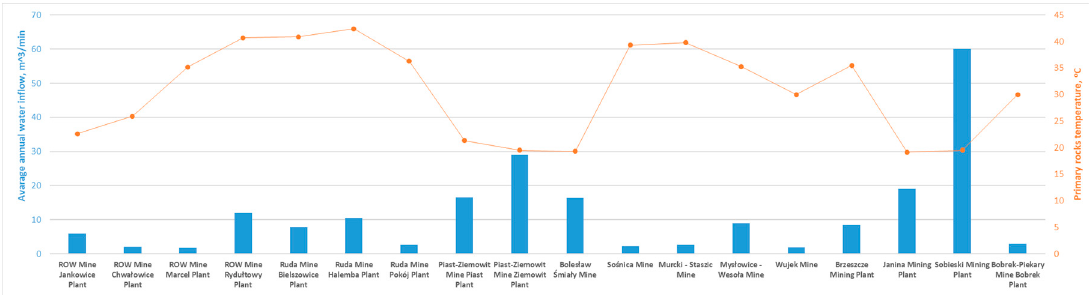
Figure 4. Summary of average inflows to mines/mining plants and the primary rock temperature, from the authors’ study.